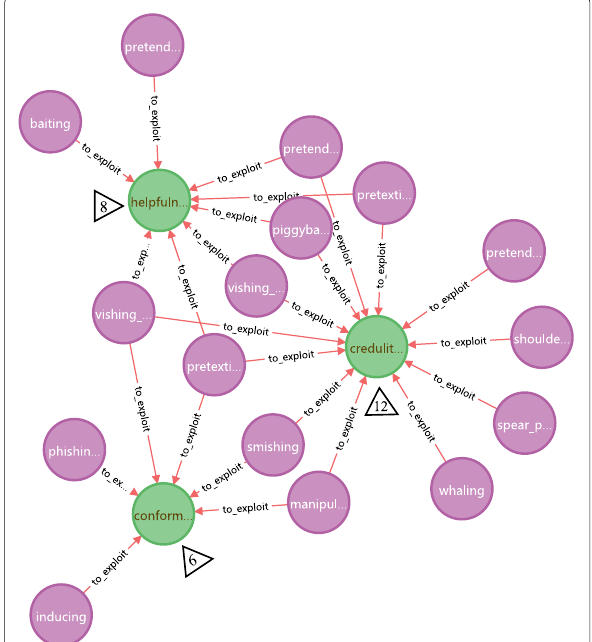
Fig. 21 Find the most exploited (top 3) human vulnerabilities